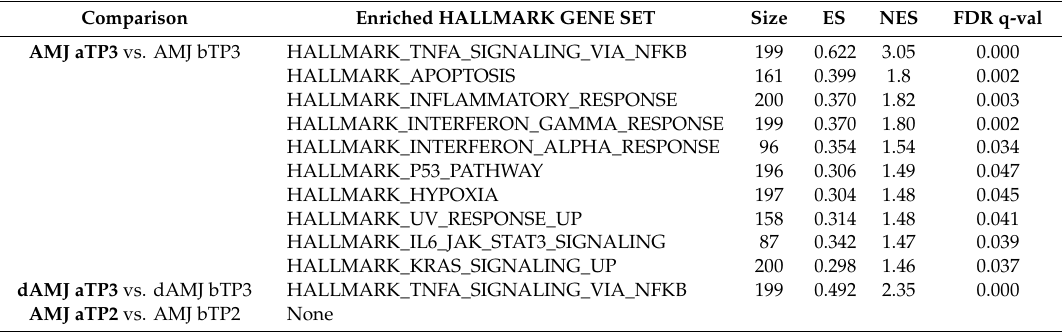
Table 2. Gene sets significantly enriched after the given treatment.